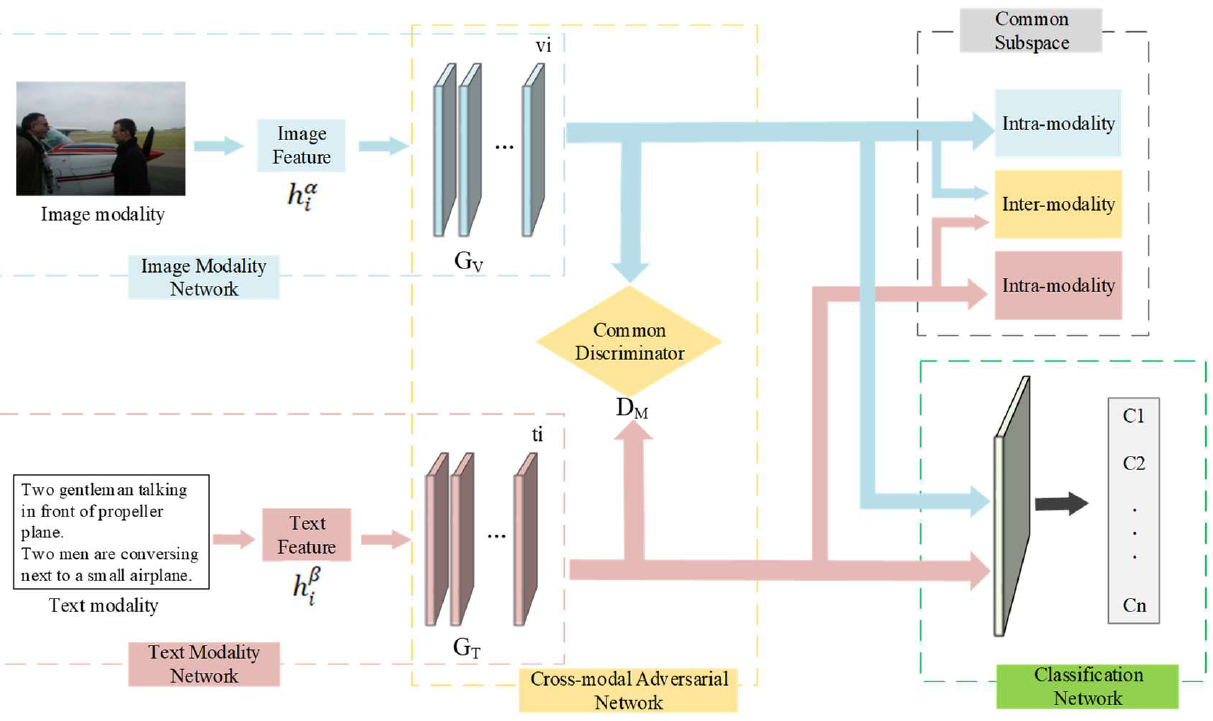
Figure 2. The framework of the proposed cross-modal retrieval algorithm.